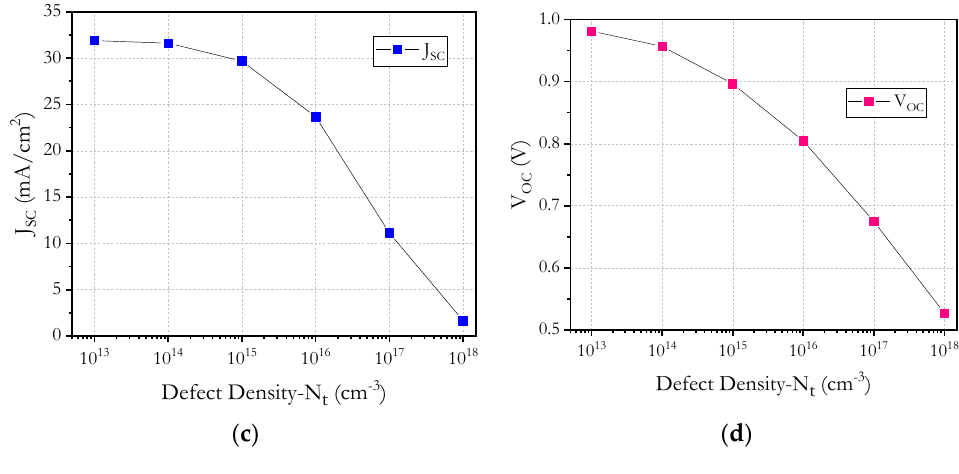
Figure 10. Absorber layer defects N t versus: ( a ) FF , ( b ) PCE , ( c ) J sc and ( d ) V oc .